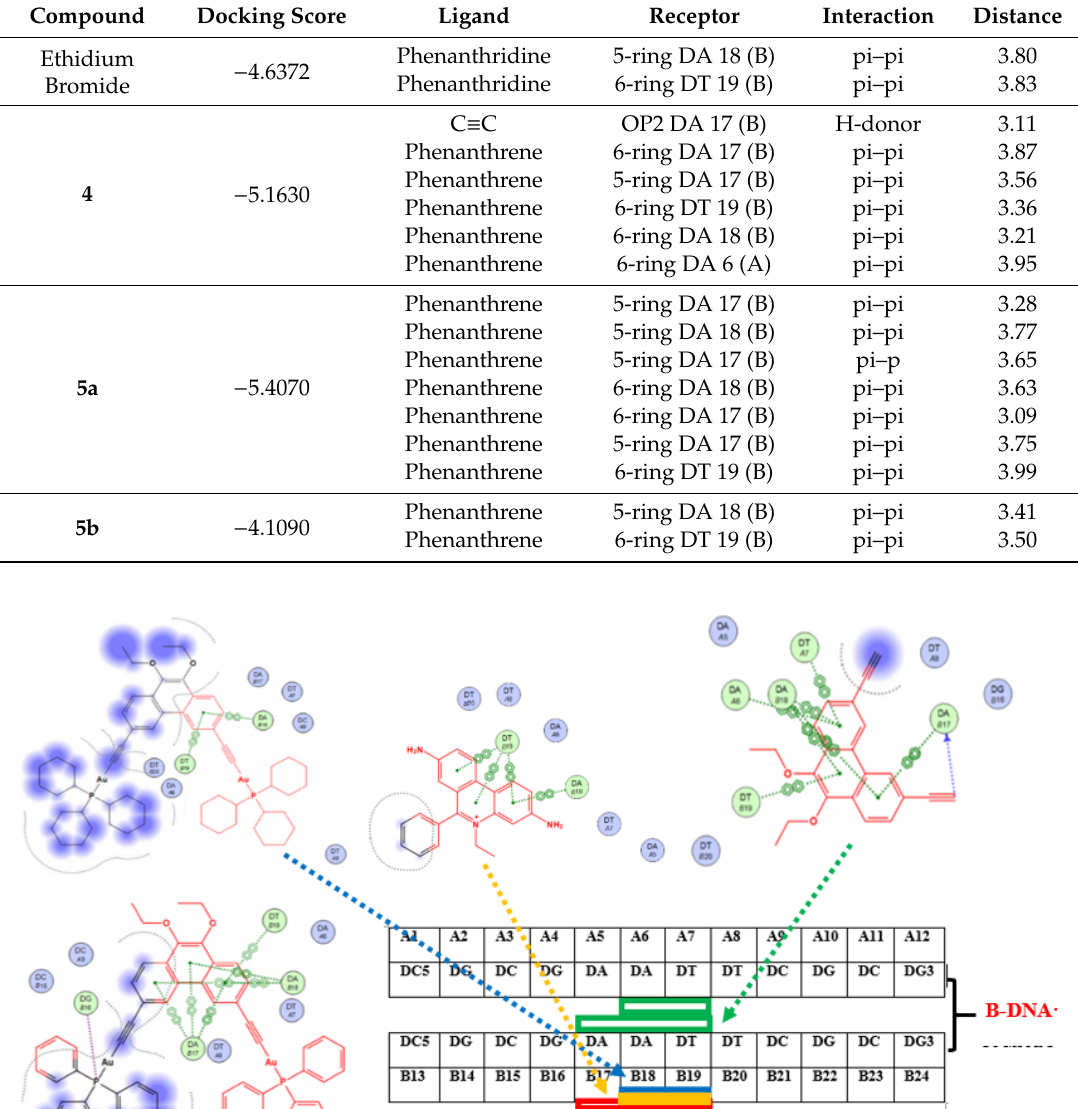
Table 2. Docking study results for 4 , 5a , and 5b .